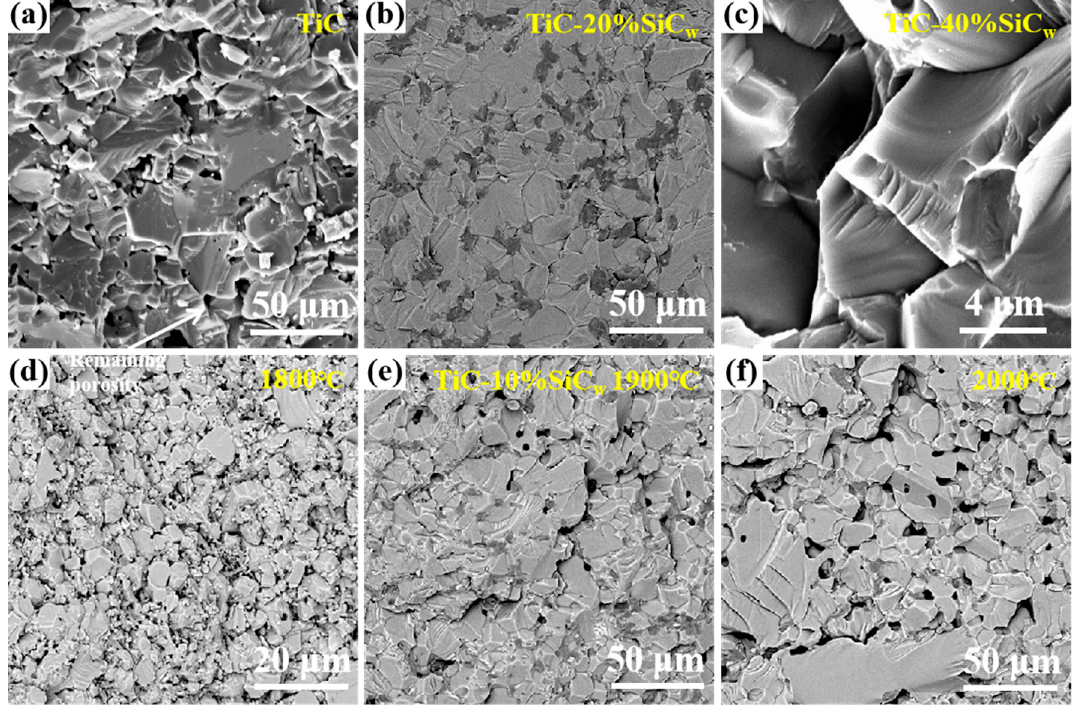
Figure 9. Microstructure of TiC-SiCW composite ceramics. ( a ) TiC, ( b ) TiC-20%SiCw, ( c ) TiC-40%SiCw. ( d ) TiC-10%SiCw sintered at 1800 °C, ( e ) TiC-10%SiCw sintered at 1900 °C, ( f ) TiC-10%SiCw sintered at 2000 °C.